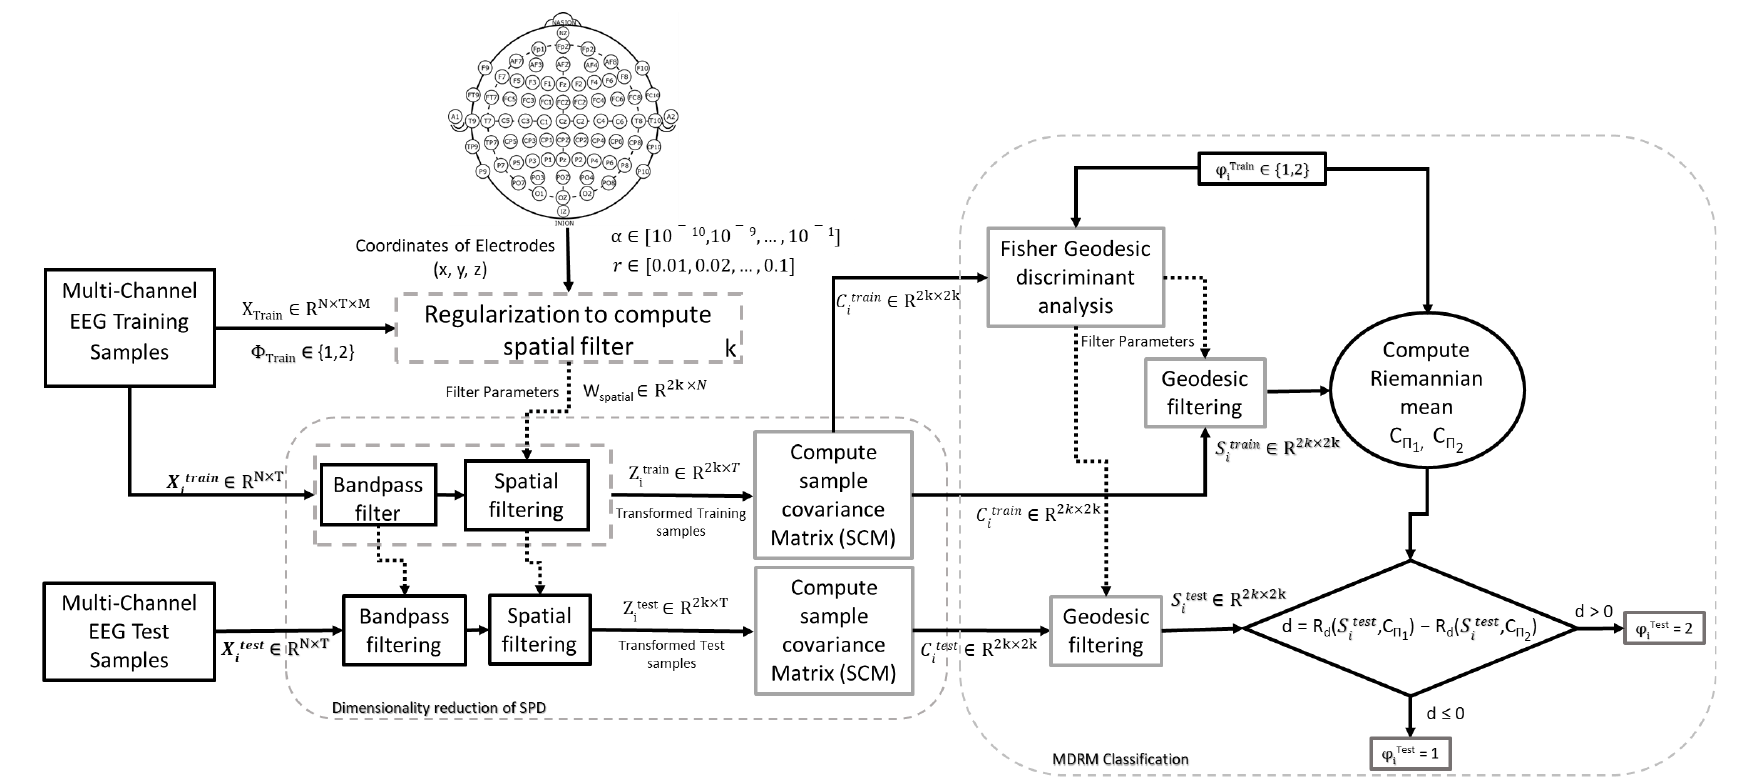
Figure 2. Framework for proposed